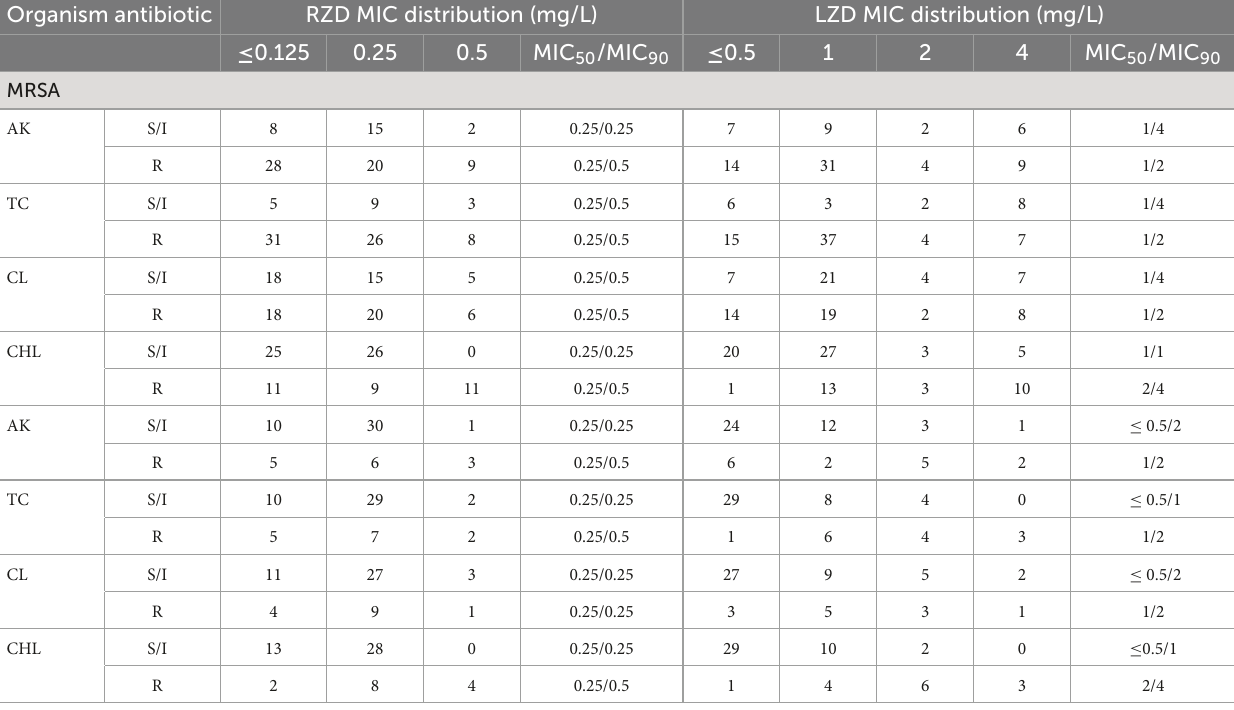
mutations of YUSA145RAD in DUF1542 domain-containing protein, glutamine-fructose-6-phosphatet ransaminase ( glmS ) and 23S ribosomal RNA are listed in Table 3 . The four genetic mutation points in 23S ribosomal RNA were found in MS4LZD. Then, S. aureus was transfected with the overexpression vector of glmS to evaluate the impact of glmS on the radezolid susceptibility, suggesting that the overexpression of the gene glmS did not change the radezolid MIC of SA113 ( Supplementary Table 3 ). In addition, the planktonic growth of glmS overexpression S. aureus strains (pcn51- glmS -1 and pcn51- glmS- 2) under the subinhibitory concentration of radezolid showed no difference when compared with the growth of the pCN51 empty vector ( Figures 1B–D ), indicating the glmS mutation might not impact the radezolid susceptibility in S. aureus . TABLE 1 Relationship of the MIC values of radezolid and linezolid with the antimicrobial susceptibility of some commonly used antibiotics against MSSA and MRSA. Organism antibiotic